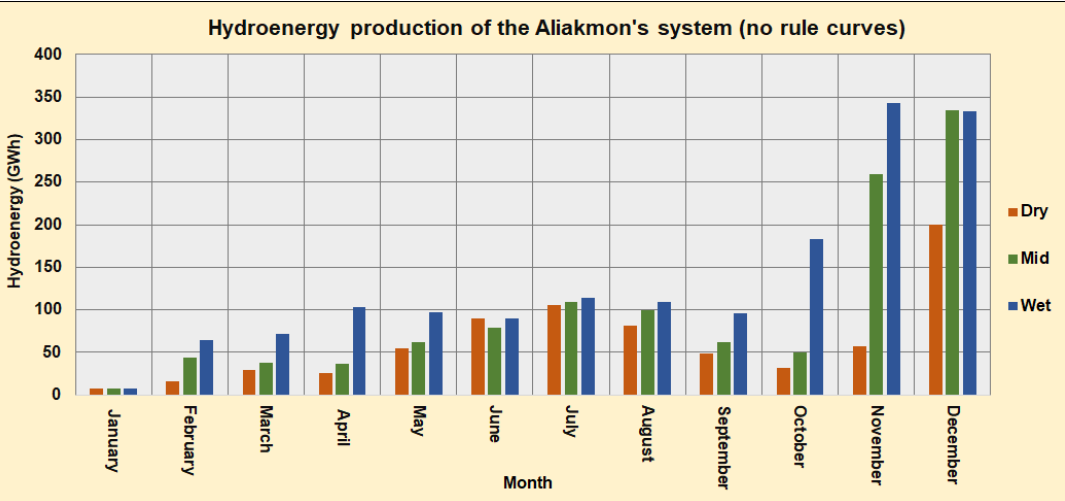
Figure 9. The optimal outflows for the current state of water resources demand, ignoring the institutional operating rule curves for Polyfyto reservoir.